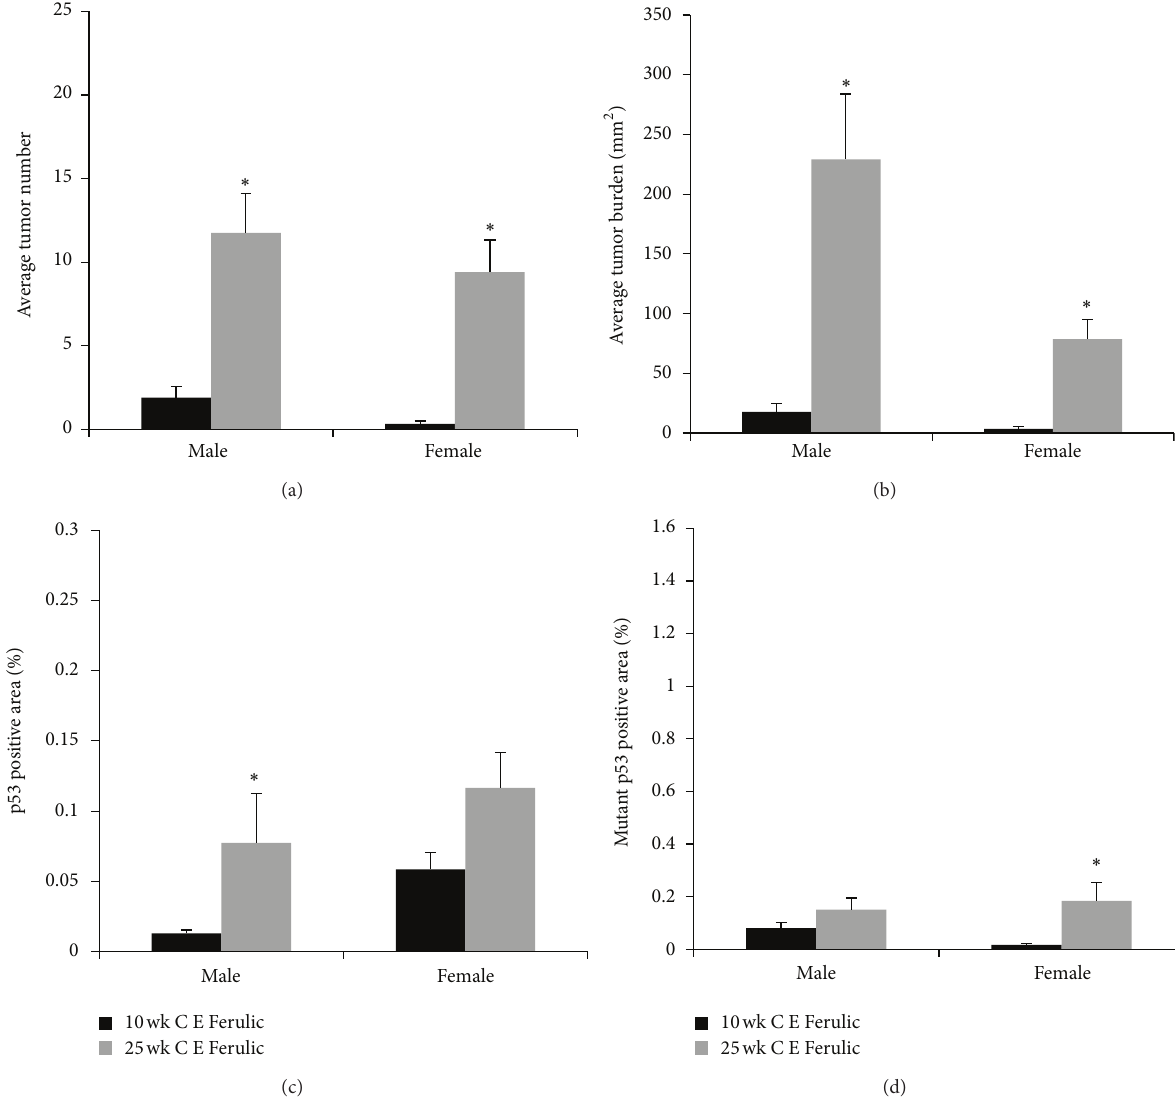
Figure 3: Efficacy of C E Ferulic on tumor number, burden, and p53 status in male and female mice. (a) Male and female mice topically treated with C E Ferulic developed more tumors in the 25- compared to the 10-week model ( ∗ 𝑃 < 0.0001 ). (b) Male and female mice topically treated with C E Ferulic developed increased tumor burden in the 25- compared to the 10-week model ( ∗ 𝑃 < 0.0001 ). (c) Male mice treated topically with C E Ferulic exhibited increased levels of epidermal p53-positive area in the 25- compared to the 10-week model ( ∗ 𝑃 = 0.0062 ). (d) Female mice treated topically with C E Ferulic exhibited increased levels of epidermal mutant p53-positive area in the 25- compared to the 10-week model ( ∗ 𝑃 = 0.0001 ). Error bars = mean+/ −